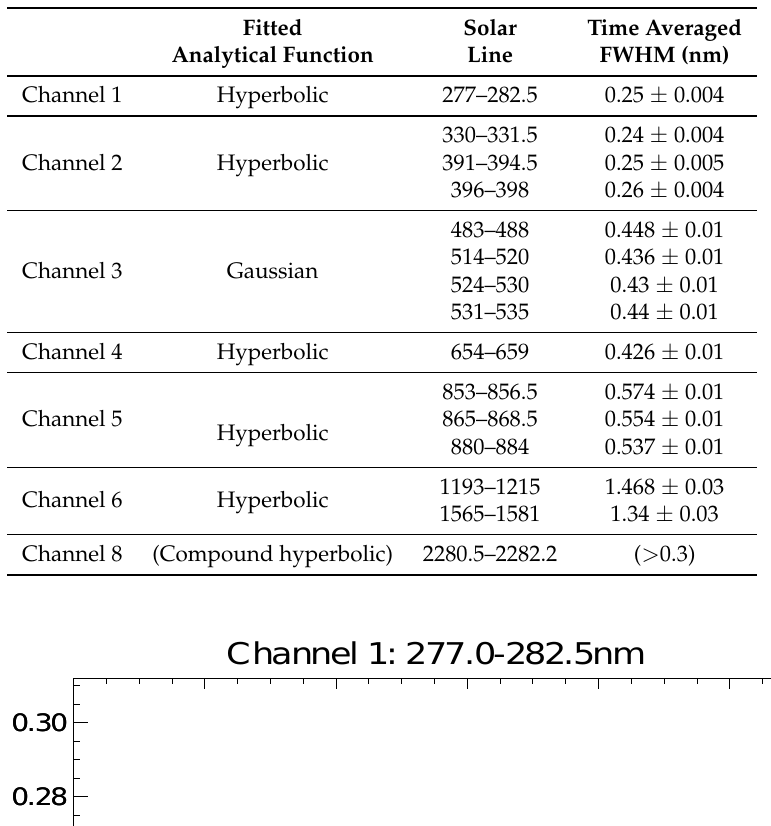
Table 4. The ISRF fitted function per channel and the averaged FWHM over the mission lifetime per measurement based on this study’s results. Channel 8 results are shown in parenthesis because of their peculiarity and also as the measured line was not fully resolved.